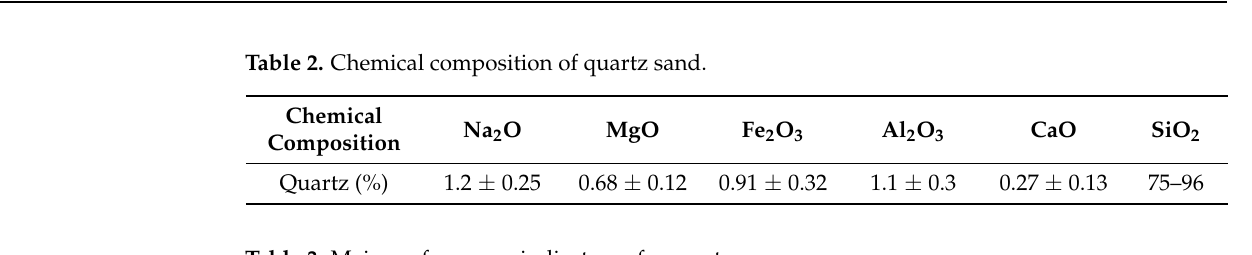
Table 3. Main performance indicators of cement.